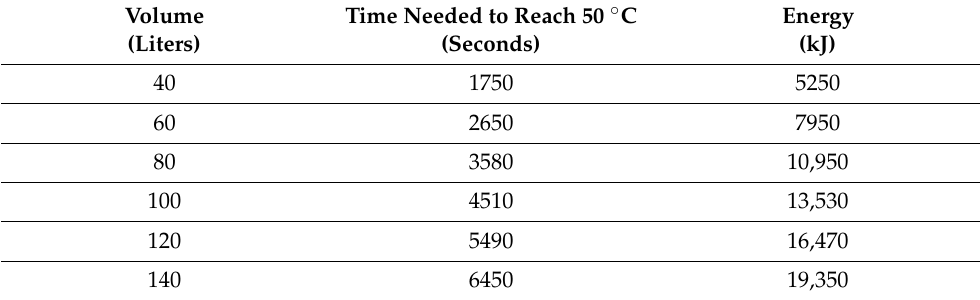
Table 3. Energy consumption for different tank